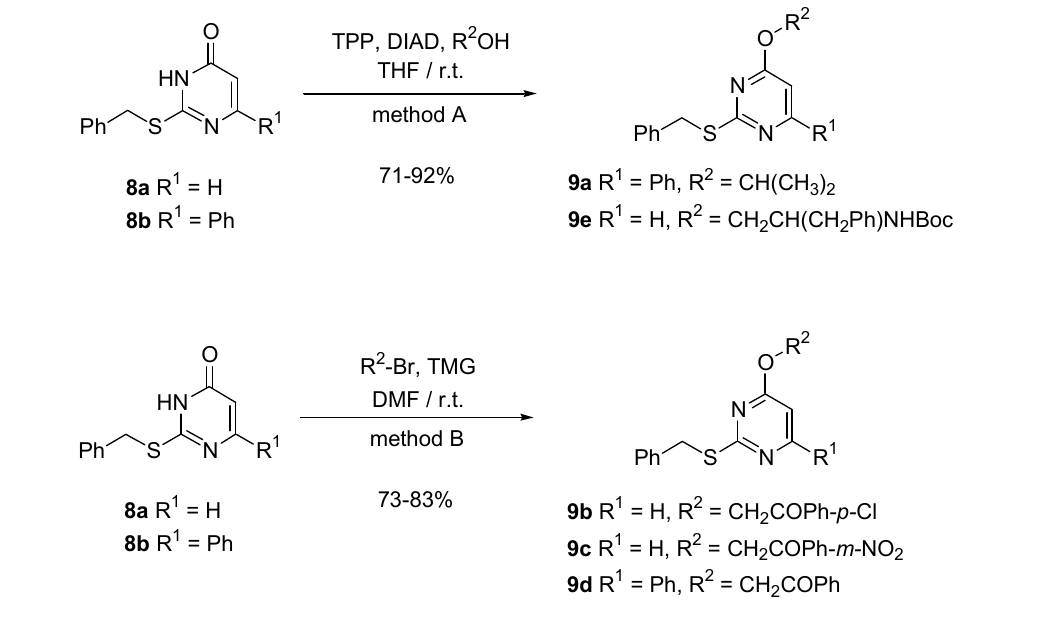
Scheme 4. O -alkylation of 2-alkylsulfanylpyrimidinones 8 . Oxidation of the thioether moiety to the corresponding sulfone 10 using m -CPBA and nucleophilic displacement by different nucleophiles produced the corresponding highly molecular diverse pyrimidines of type 11 . In addition, when 4-isopropoxipyrimidine 11a was treated with a 1:1 mixture of H 2 SO 4 /AcOH at 90 ◦ C for 15 min, the selective cleavage of the 4-isopropoxy group took place yielding 2-aryloxypyrimidinone 12 (Scheme 5).